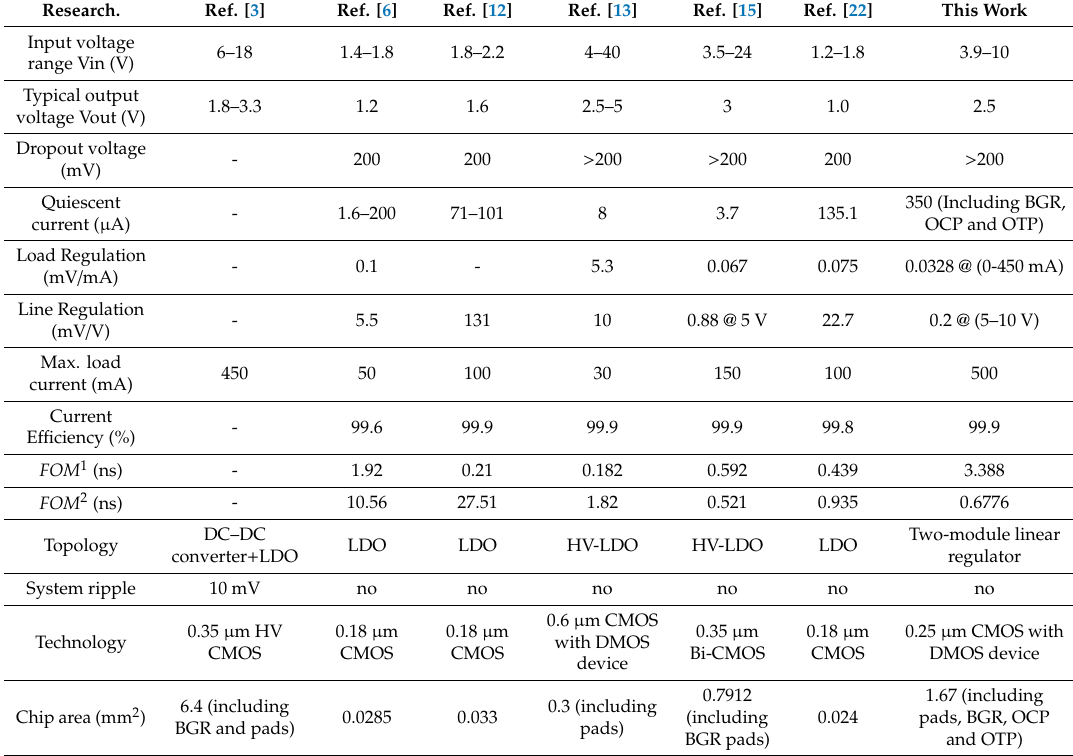
Figure 14. Measured load transient performance of the proposed linear regulator with supply voltage of 6 V. ( a ) Load current step is from 0 to 450 mA; ( b ) load current step is from 0 to 200 mA. Table 3. Performance summary and comparisons of other studies.